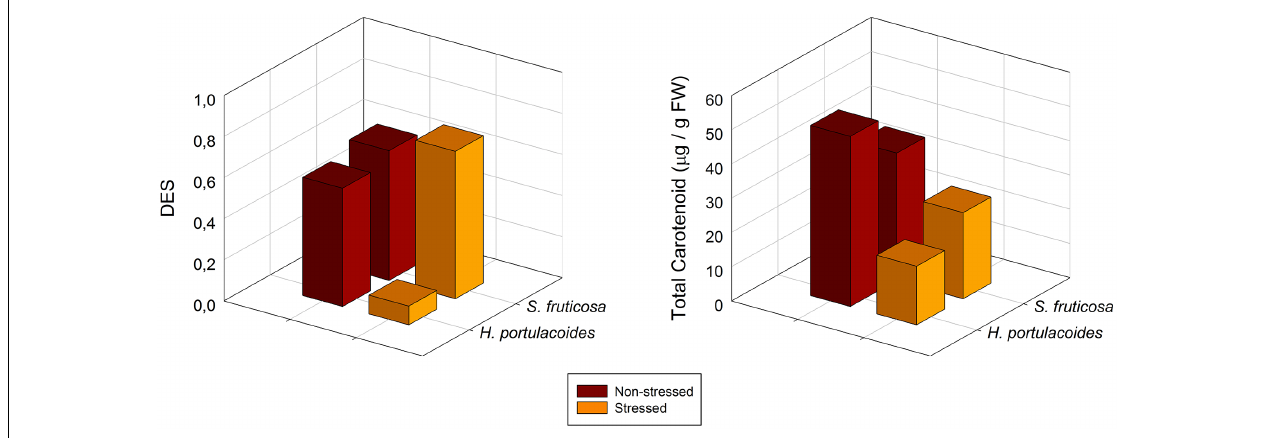
FIGURE 11 | De-epoxidation state (DES) and total carotenoids in S. fruticosa and H. portulacoides field stressed (orange) and non-stressed individuals (brown; average ± SE, N =